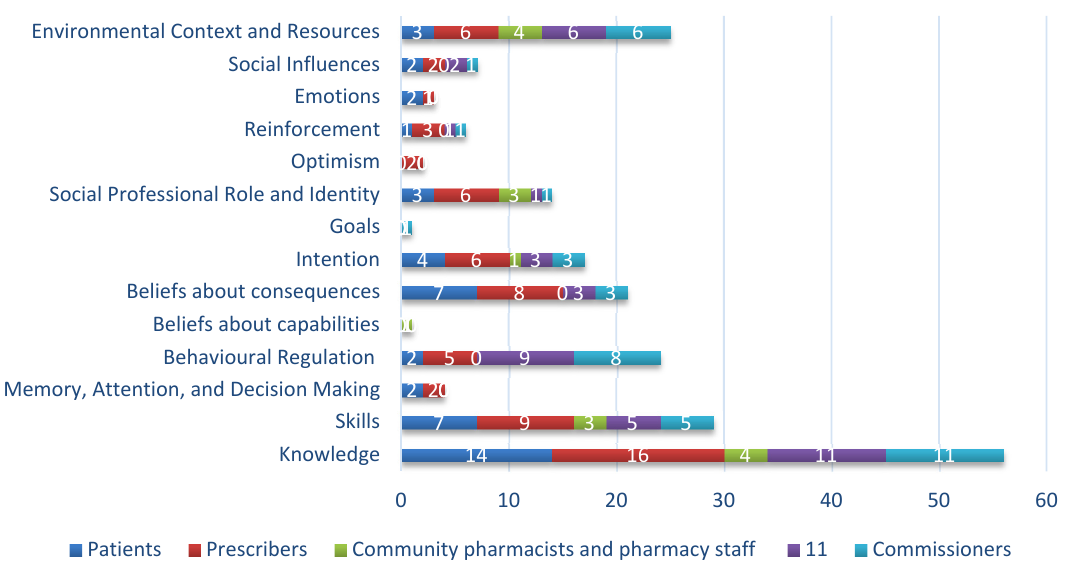
Figure 5. Influences (Theoretical Domains Framework (TDF)) on behavior targeted in interventions, by target